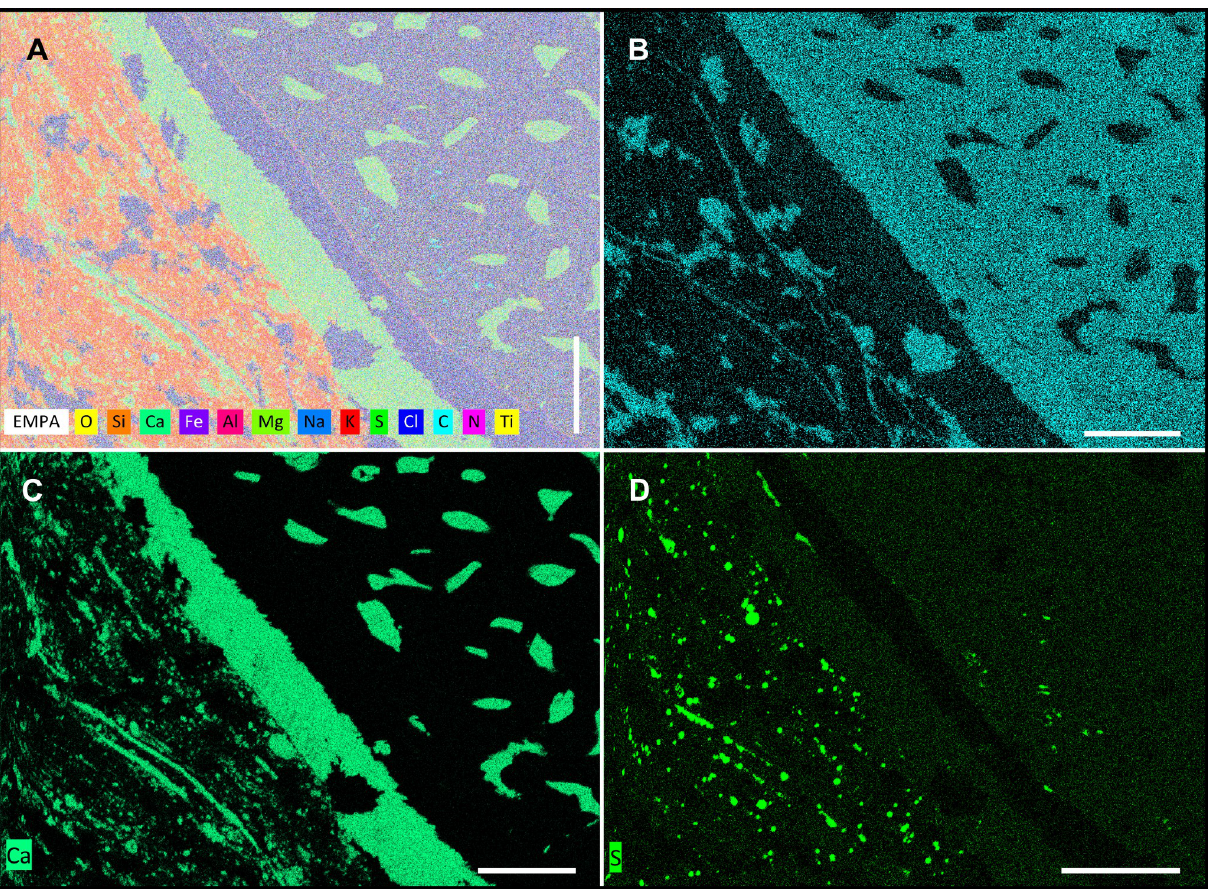
Fig 6. Microprobe analysis reveals the elemental distribution near the sediment-fossil boundary. (A) Composite image of elements in thin-section of specimen NHMW 2012/0117/0024. Aluminium, silicon and oxygen are the main sediment constituents. (B) Carbon is the dominant element in the black fossil structure. (C) Calcite-filled channels and the fossil surrounding calcitic seam/layer. (D) Distribution of sulfur in the sediment corresponds to pyrite nodules. Note the outer dark layer of the fossil, lacking sulfur. All scale bars 100 μ m.